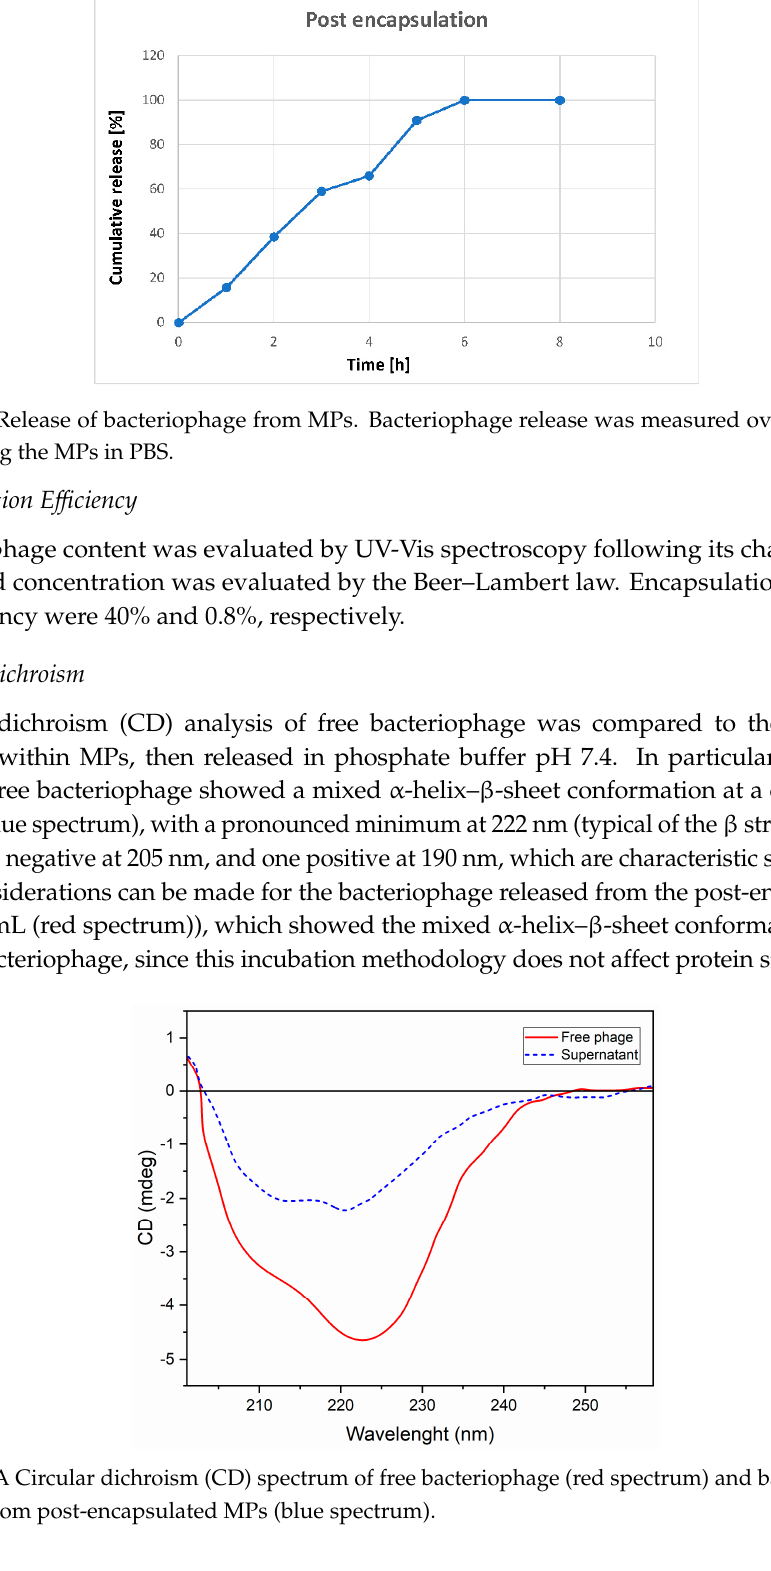
Figure 6. UV spectrum fd ‐ OVA and fd ‐ OVA FITC. A. Rhodamine ‐ loaded ‐ MP confocal microscopy analysis. Rhodamine channel ( λ exc 550, λ em 600–700). B. FITC channel ( λ exc 488, λ em 500–600). C. Overlay of the channels.